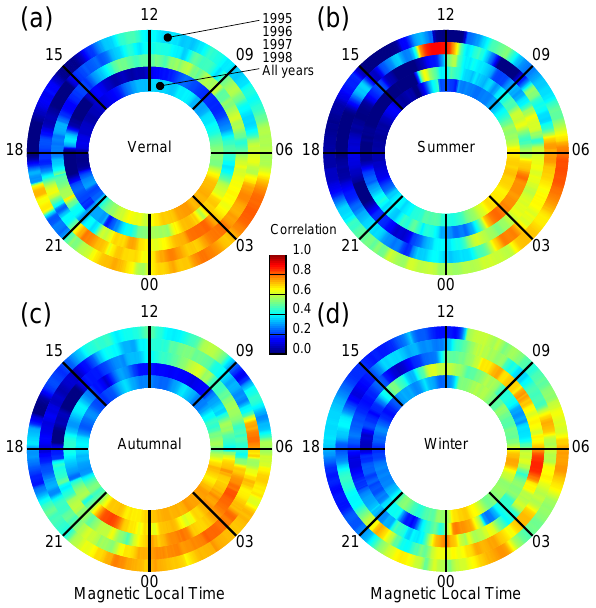
Fig. 7. Clock diagrams showing the correlation co-efficients be- tween magnetic perturbations and absorption for 1-h boxcar cor- relations calculated at 1-min resolution for different seasons. The colour coding is representative of the correlation as indicated by the colour bar. The circular bands in each panel represent different years as indicated at the top of the